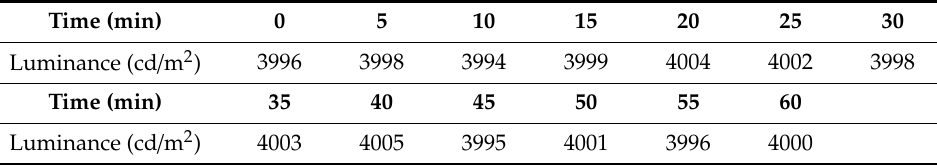
Table 3. Stability of the light